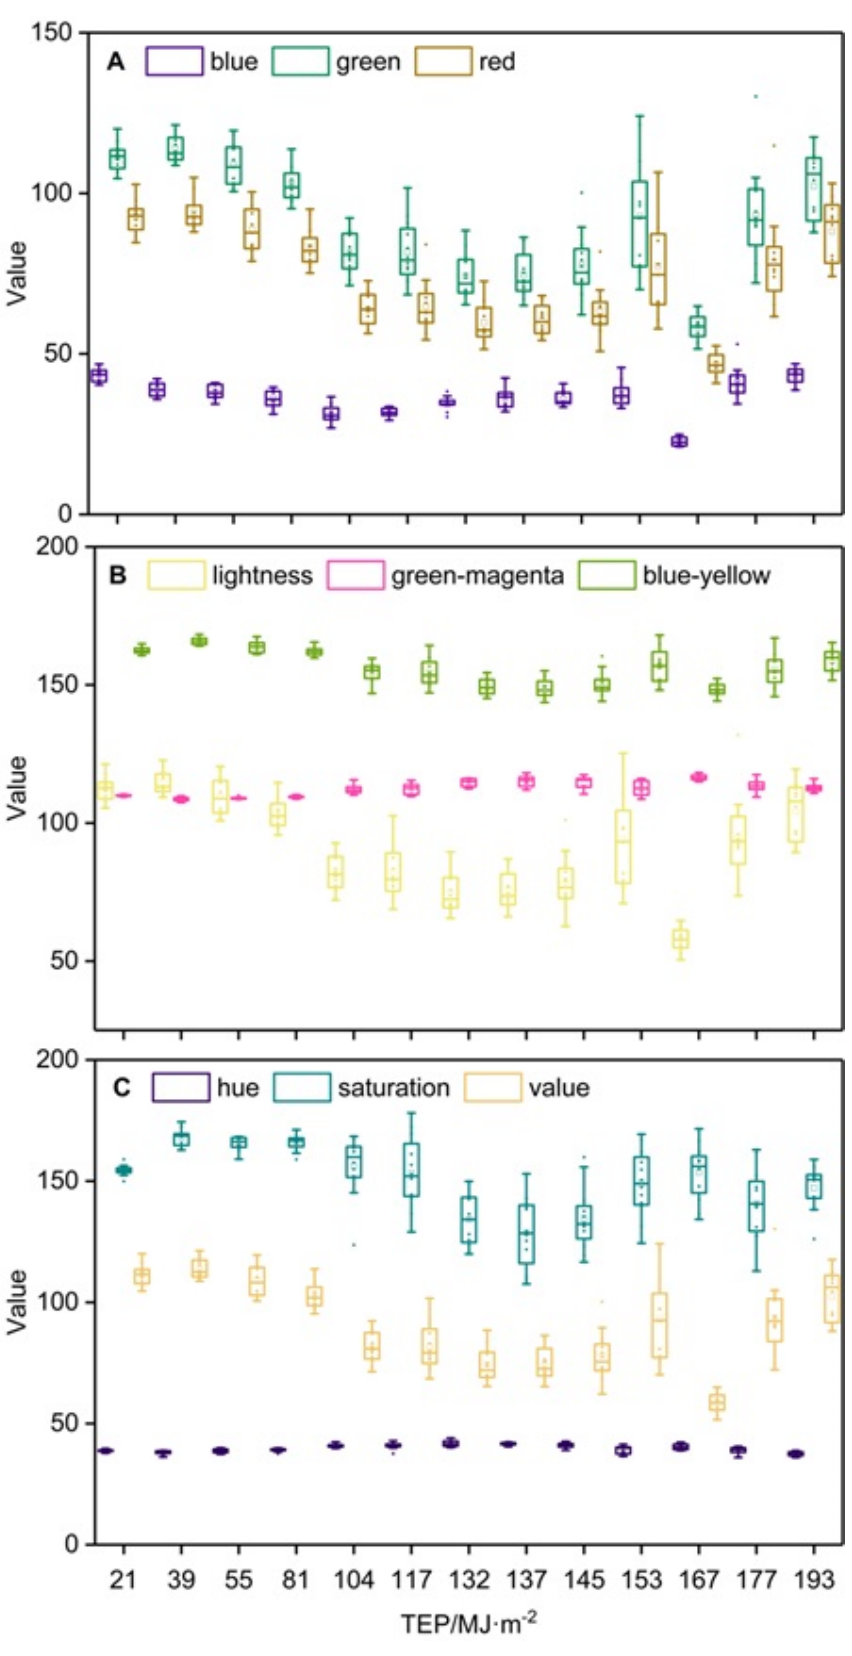
Figure 8. Effect of air temperature on leaf color. Note: ( A ) RGB, ( B ) LAB and ( C ) HSV.